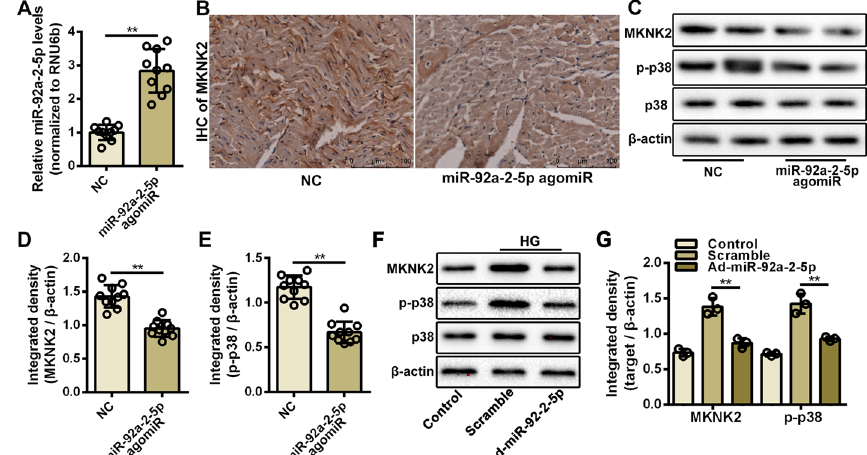
P < 0.01. B Representative images of immunohistochemistry (IHC) for MKNK2 in rat left ventricle tissues from the NC and miR-92a-2-5p agomiR groups. Scale bar blot for MKNK2 and p38 proteins in NC and miR-92a-2-5p agomiR groups. D , E Integrated density analysis of immune bands using ImageJ software. β-actin was used as a loading control. n ** P < 0.01. F Representative images of western blot for MKNK2 and p38 proteins in cardiomyocytes infected with Ad-miR-92a-2-5p under high glucose stimulation. G Integrated density analysis of immune bands using ImageJ software. β-Aactin was used as a loading control. n